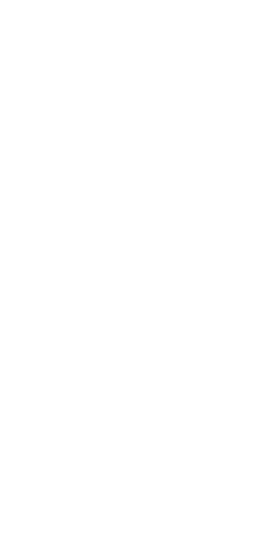
Figure 1 The innovative model of tiered primary healthcare for COVID-19 control in Taiwan.CHGPC = community healthcare groups prepared clinics. CSS = community screening stations. Tx =